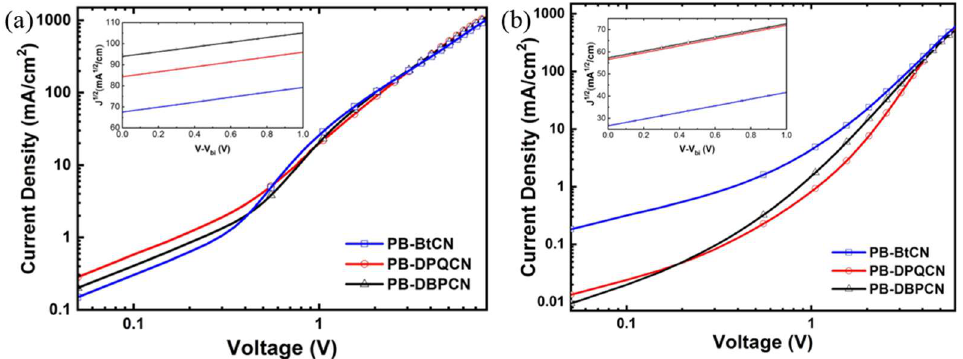
Figure 6. Current density vs. voltage ( a ) hole- and ( b ) electron- devices (inset: current density vs. voltage—built-in voltage (V bi ) curves with fitted lines) based on PB–BtCN, PB–DPQCN, and PB– DBPCN.